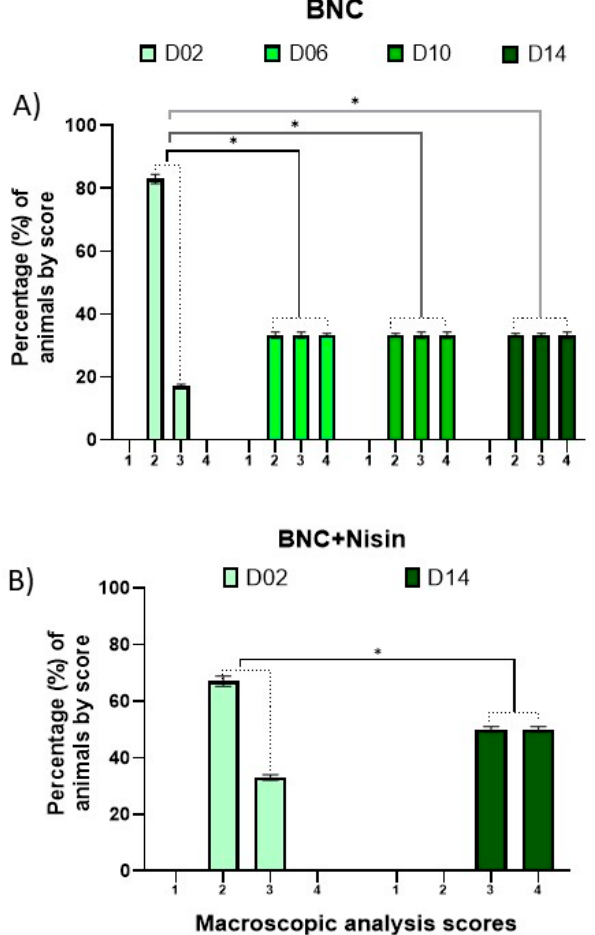
Figure 4. Influence of time for intragroup analysis of healing process ( n = 12). Macroscopic evaluation of surgical wounds of animals from Experiment II. In ( A ) BNC group = standard treatment + bacterial nanocellulose membrane; comparison of data among days 2, 6, 10 and 14; * p < 0.05. In ( B ) BNC+Nisin group = standard treatment + Nisin loaded in bacterial nanocellulose membrane; comparison of data among days 2 and 14; * p < 0.05.